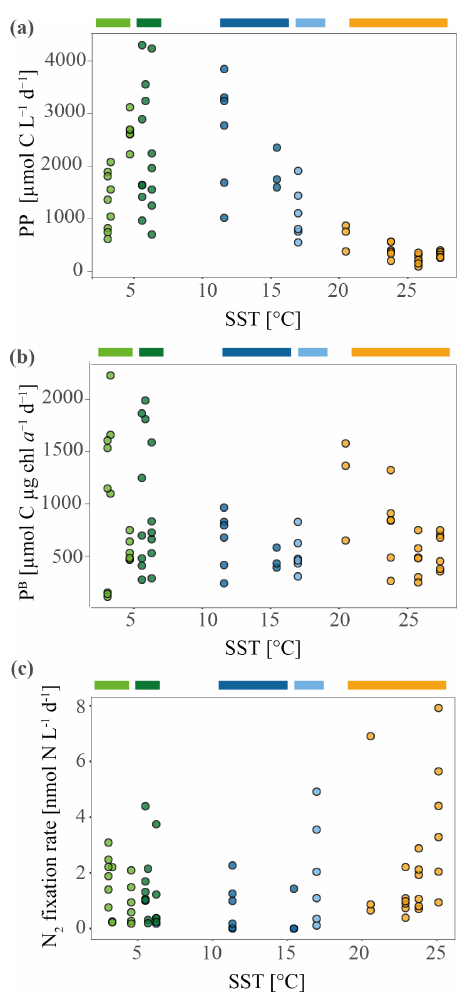
Figure 3. Primary productivity (PP) and specific primary productiv- ity ( P B ) measured during the MD206 cruise. (a) PP in micromole carbon per liter per day against sea surface temperature (SST) in degrees Celsius ( ◦ C). (b) P B , normalized by chl a concentration. (c) Nitrogen fixation rates against sea surface temperature (SST) in degrees Celsius measured during the MD206 cruise. Rates are shown in nanomole nitrogen per liter per day. Colored bars indicate water masses: yellow bar highlights the Indian South Subtropical Gyre (ISSG), light blue bar highlights the Subtropical Front (STF), dark blue bar highlights the Subantarctic Front (SAF), dark green bar highlights the Polar Front Zone (PFZ), and light green bar marks the Antarctic Zone